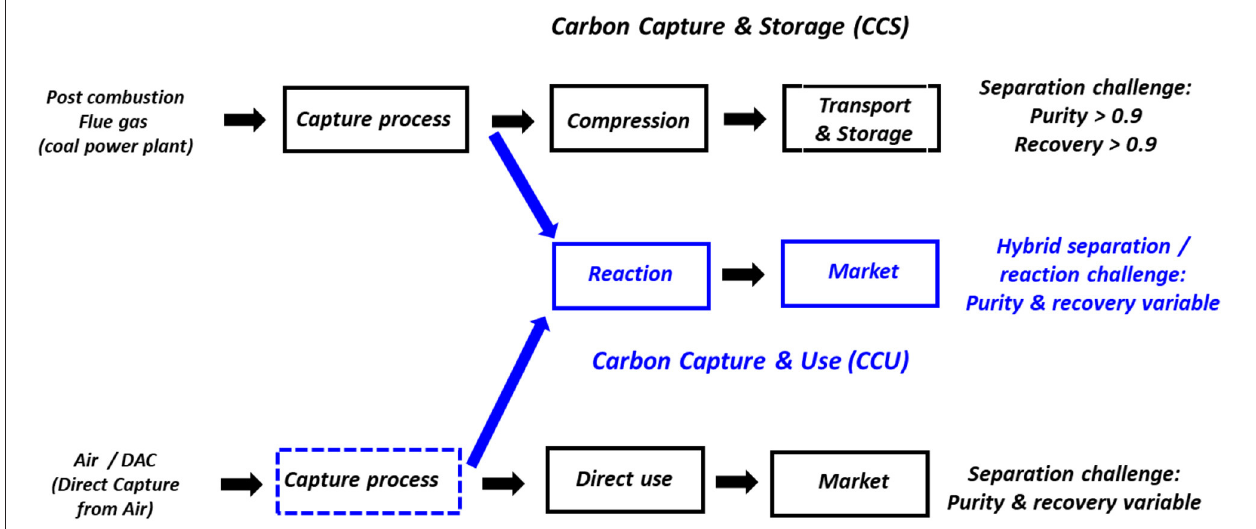
FIGURE 1 | Simplified representation of Carbon Capture and Storage (CCS), Carbon Capture and Use (CCU), and Direct Air Capture (DAC). DAC can be used either for direct use of CO 2 or chemical transformation and requires a capture process. The dotted blue rectangle shows the scope of this